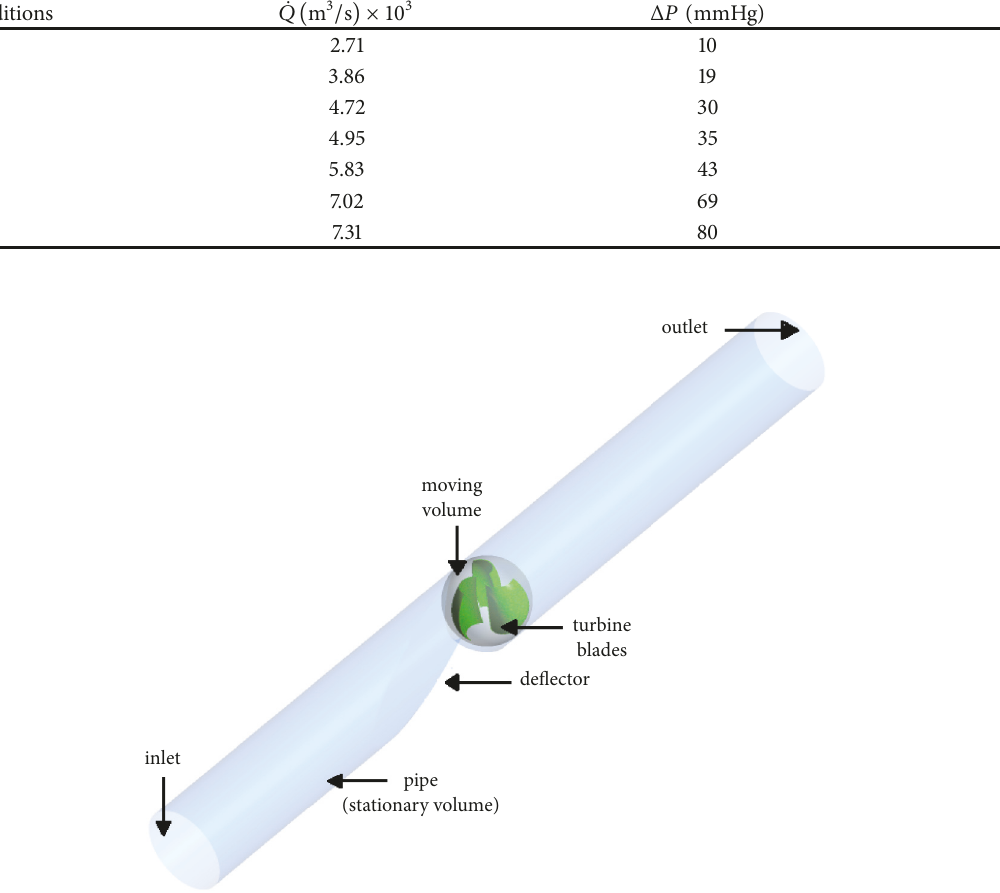
Table 2: Test results in turbine different operating conditions.